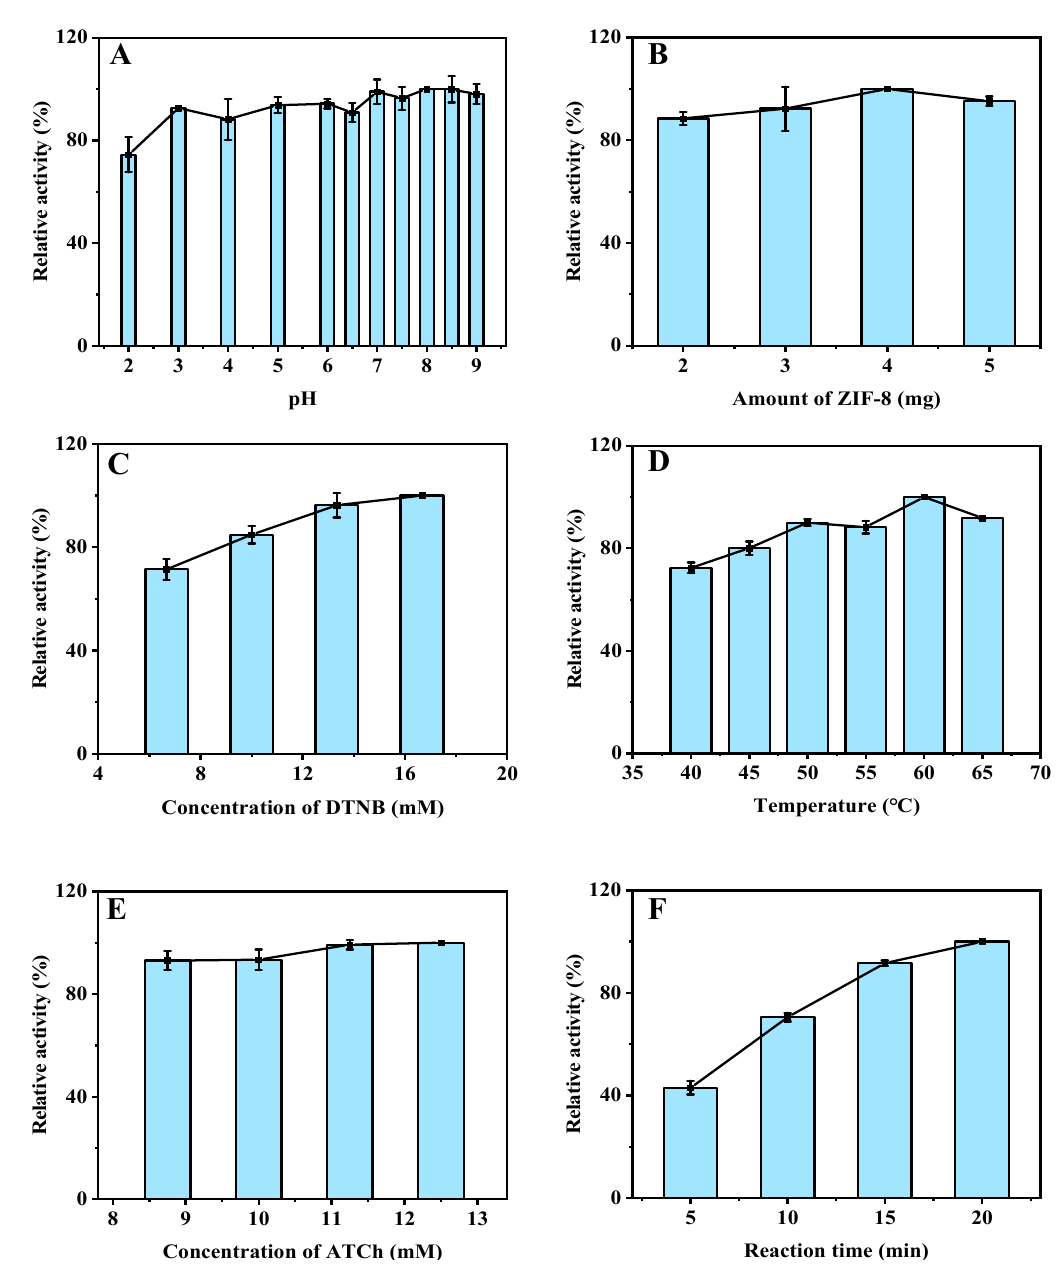
Figure 3. Effects of buffer pH ( A ), amount of ZIF-8 ( B ), concentration of DTNB ( C ), incubation temperature ( D ), concentration of ATCh ( E ), and reaction time ( F ) on the AChE-like activity of ZIF-8 for the detection of Cu 2+ . Buffer pH, 7.5 for ( B – F ); ZIF-8, 2 mg for A , 4 mg for ( C – F ); DTNB, 6.7 mM for ( A , B , D – F ); incubation temperature, 50 ◦ C for ( A – C ), 60 ◦ C for ( E , F ); ATCh, 5.0 mM for ( A – D ), 11.3 mM for and F; reaction time, 5 min for ( A – E ); centrifugation time, 1 min for ( A – F